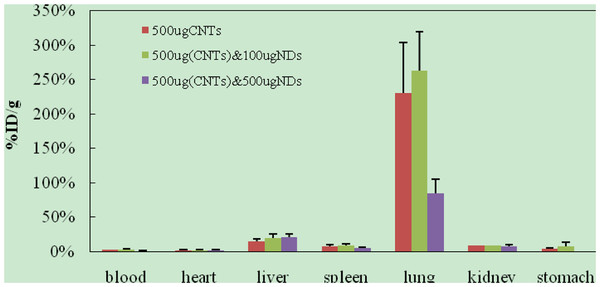
Effect of NDs doses on biodistribution of 500 μg 99mTc-oMWCNTs in mice 2 h after co-injection.